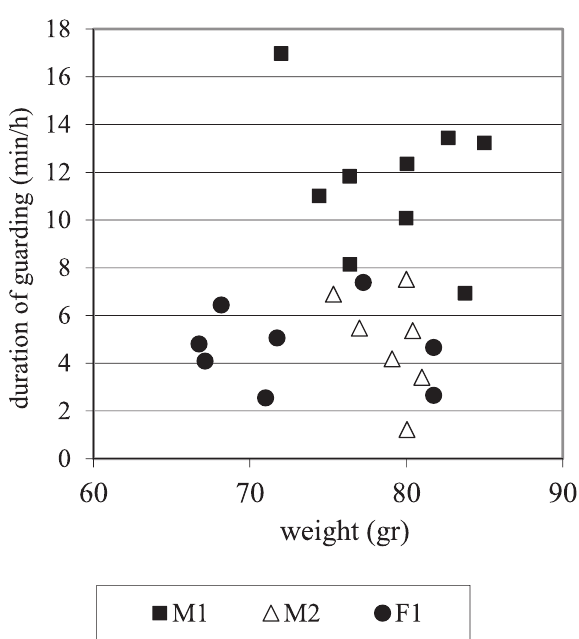
Figure 4. Relationship between a babbler’s weight (g) and its duration of guarding